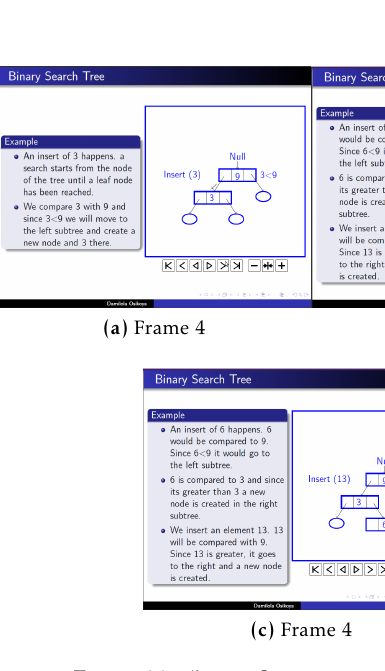
Figure 10. (Insert Operations in a Binary Tree)